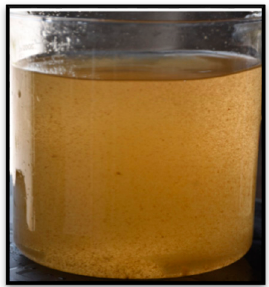
Figure 1. Beaker with water sample, where they observe bioflocules in suspension. Source: Photographs provided by David Celdran Sabater (2020).